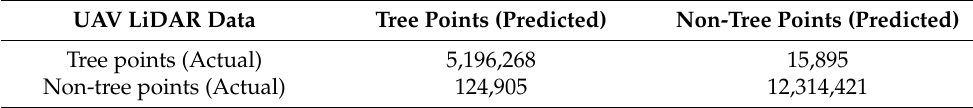
Table 3. Confusion matrix for UAV LiDAR data extraction